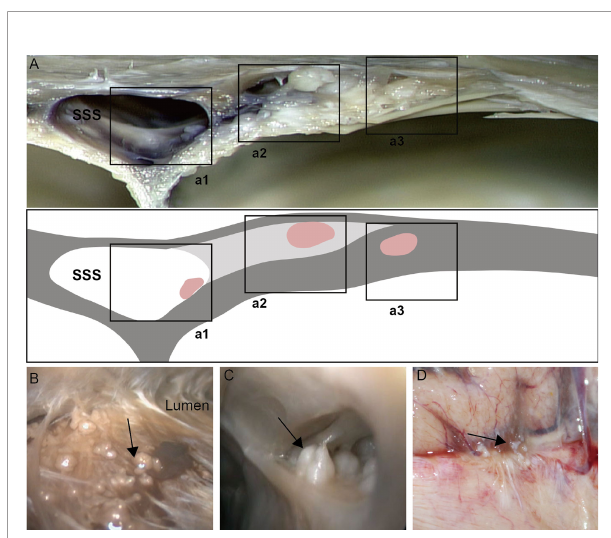
FIGURE 1 | Distribution of arachnoid granulation (black arrow) in cerebral venous sinus. Arachnoid granulation in the lumen (a1, B) , lateral sinus (a2, C) and subarachnoid space (a3, D) .